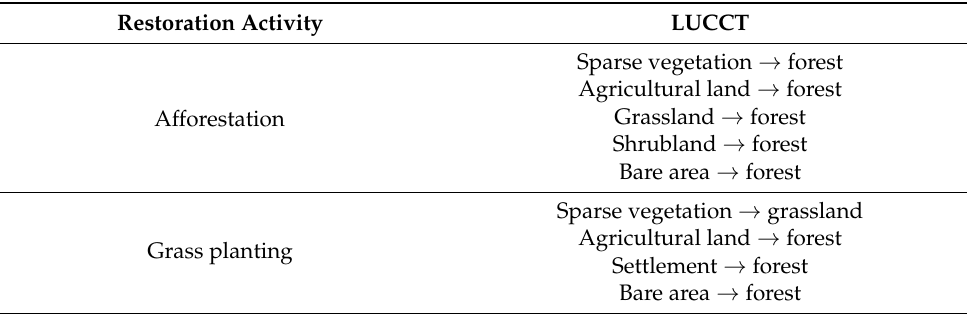
Table 1. Definition of LUCCT for afforestation and grass planting in Southwest